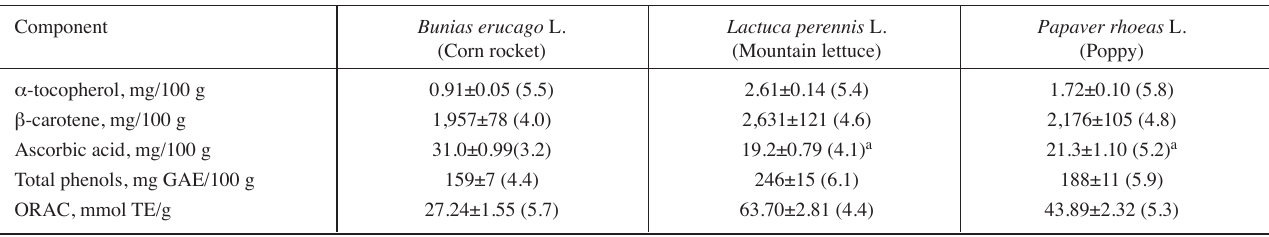
Tab. 4: a -tocopherol, b -carotene, total ascorbic acid, total phenol content and antioxidant capacity of raw edible wild plants. In parentheses the repeatability relative to standard deviation (RSD r ) is